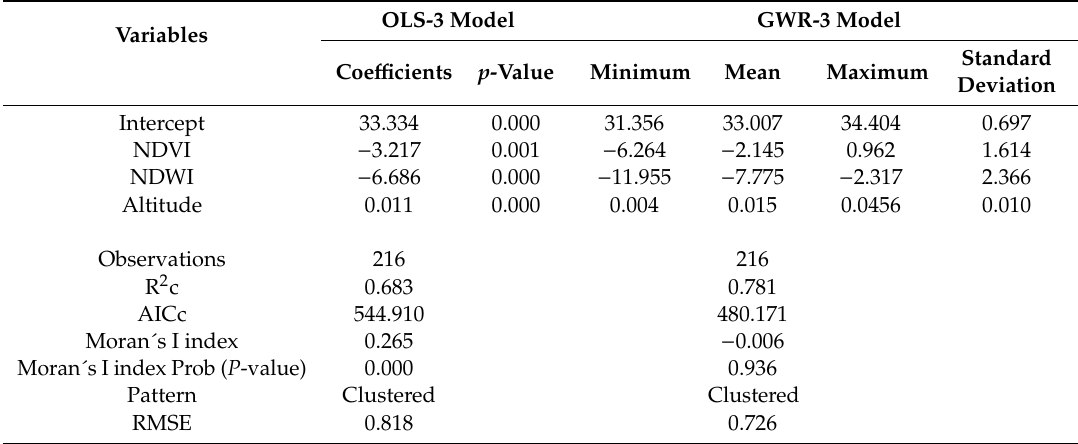
Table 3. Results for the third OLS and GWR regression models.